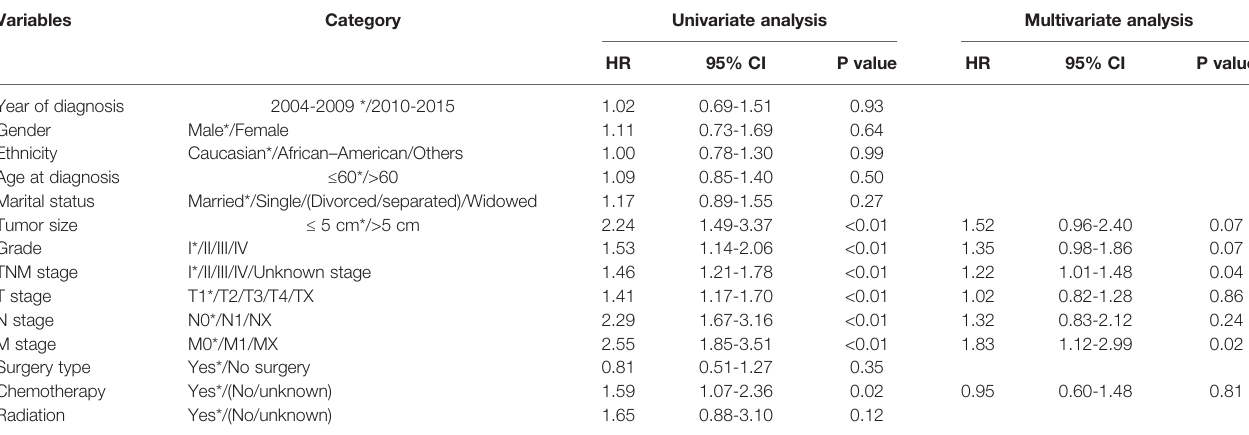
TABLE 3 | Univariate and multivariate analyses of prognostic factors of combined hepatocellular carcinoma and cholangiocarcinoma patients undergoing surgery. Variables Category Univariate analysis Multivariate analysis HR 95% CI P value HR 95% CI P